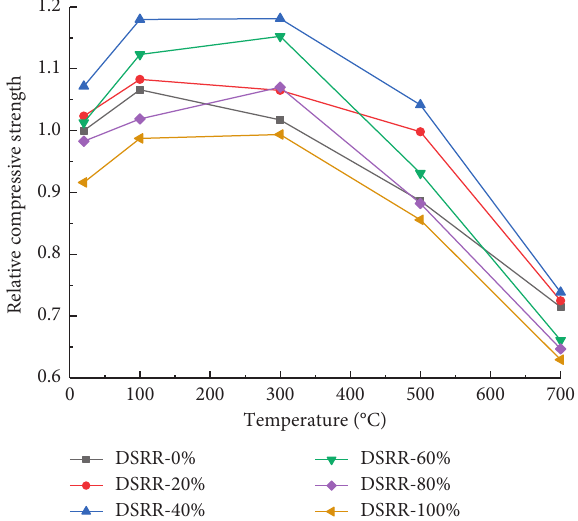
Figure 9: Relation between mass loss rate and temperature.